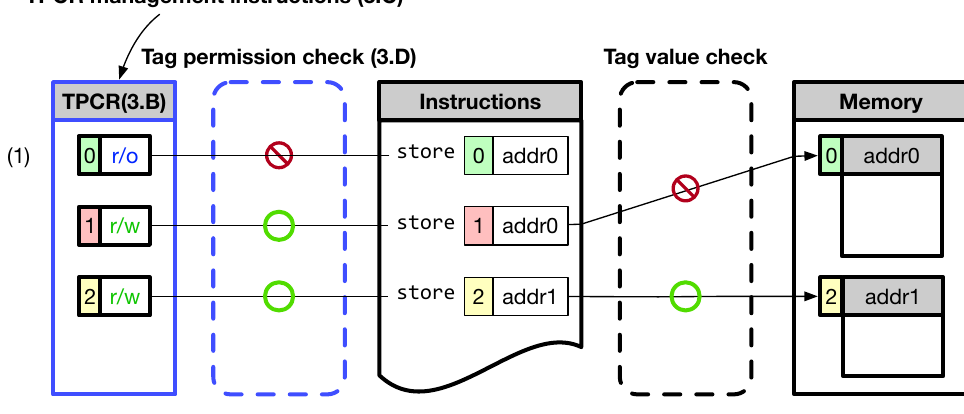
Figure 2. Overview of CoMeT .